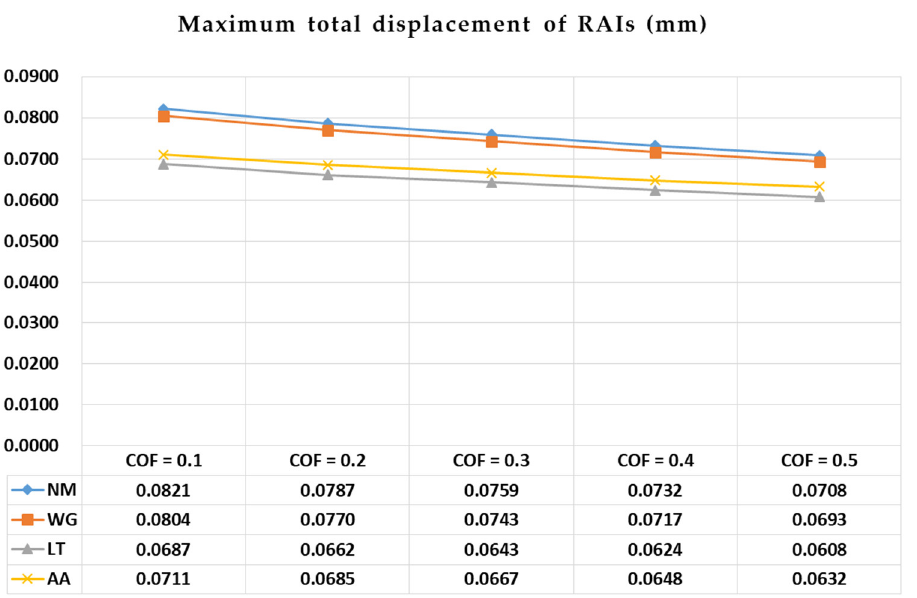
Figure 10. Micro-displacement values of root analogue implants (RAIs) in each experimental group according to all frictional coefficient (COF) values.